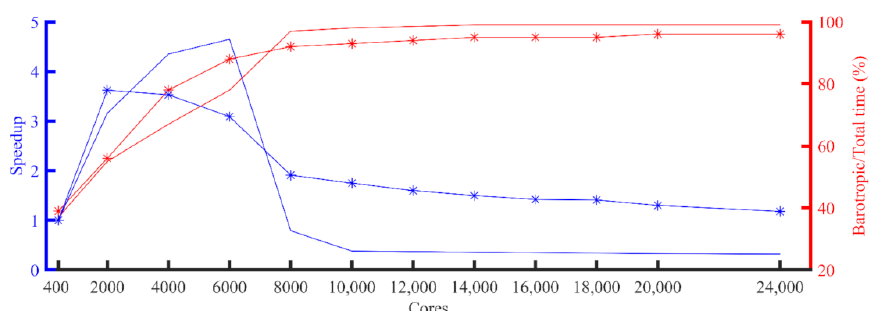
Figure 7. Speedup of 5-km NEMO experiments using the PCG (solid blue line) and CA-PCG (blue solid-star line) solvers. Percentages of the barotropic time of the total execution time using the PCG (solid red line) and CA-PCG (red solid-star line) solvers.